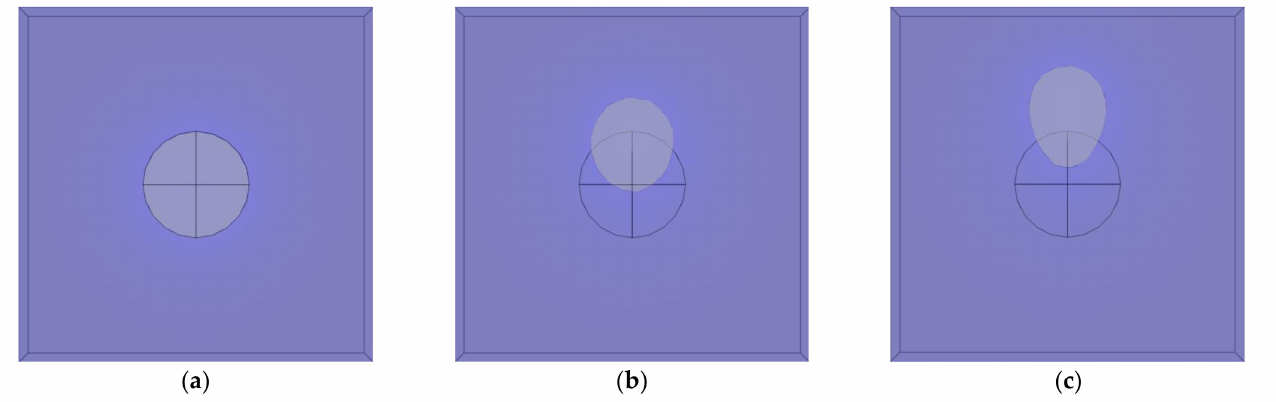
Figure 12. ( a ) Bubble at 0 s; ( b ) Bubble at 0.025 s; ( c ) Bubble at 0.035